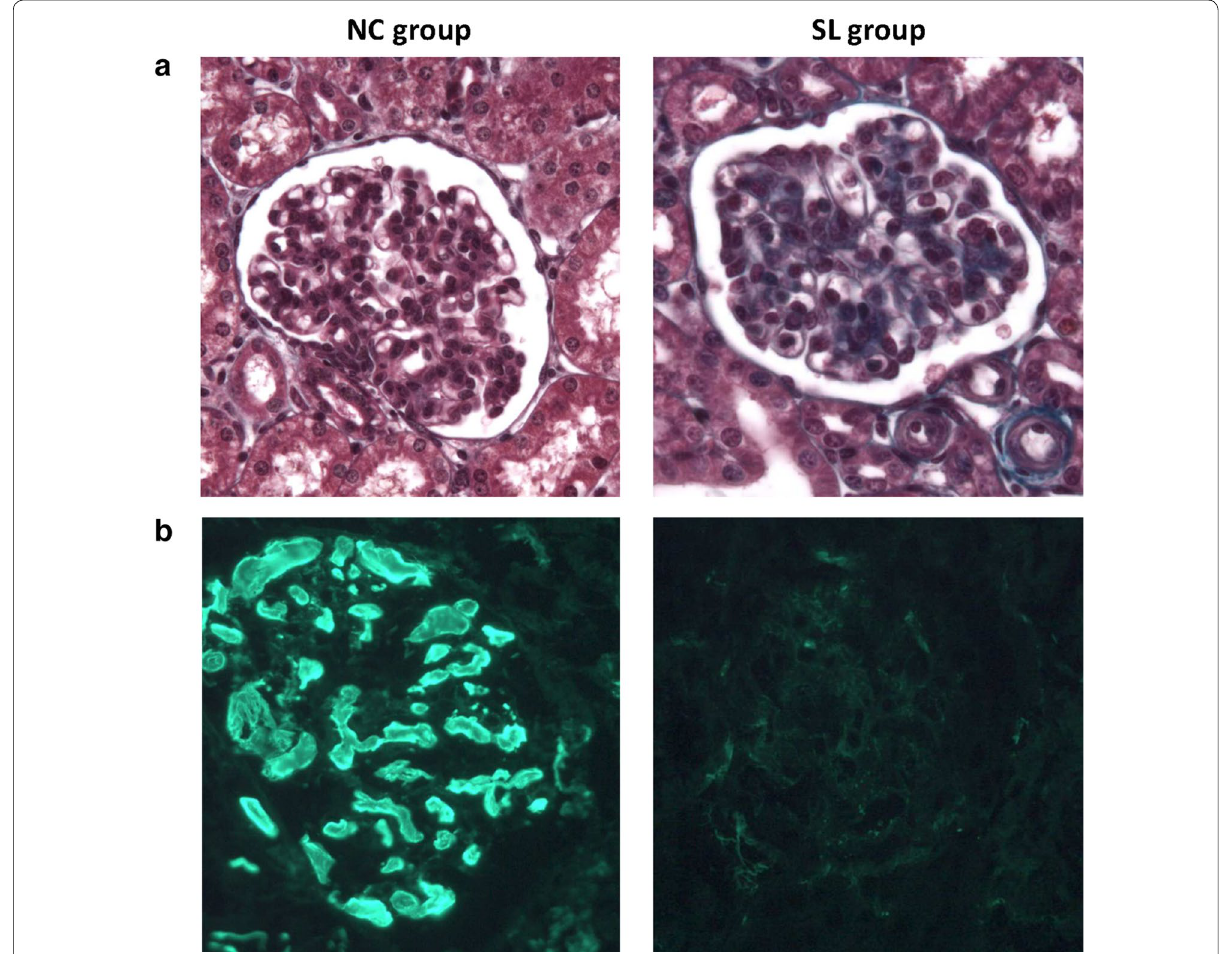
400) ( a ) and immunofluo‑ ×